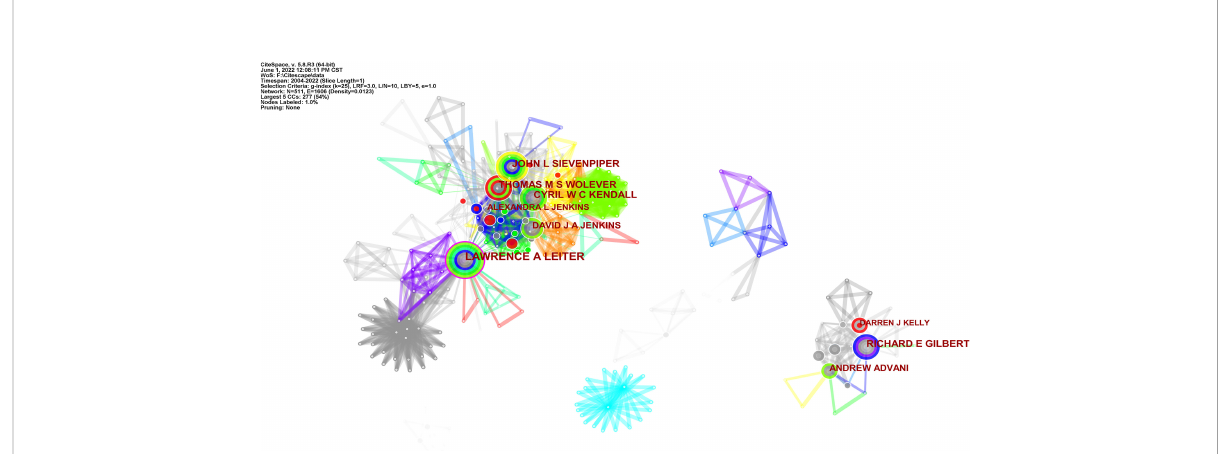
FIGURE 7 Visualization map of the top fi ve author collaboration related to RNA methylation in DM and its complications. Each node with colorful annual rings represents an author. The size of the nodes matches the publications of the author. The nodes circled in purple represent greater centrality; the nodes circled in red represent higher burst. The separate areas made up of nodes and links represent the author collaborative relationships.